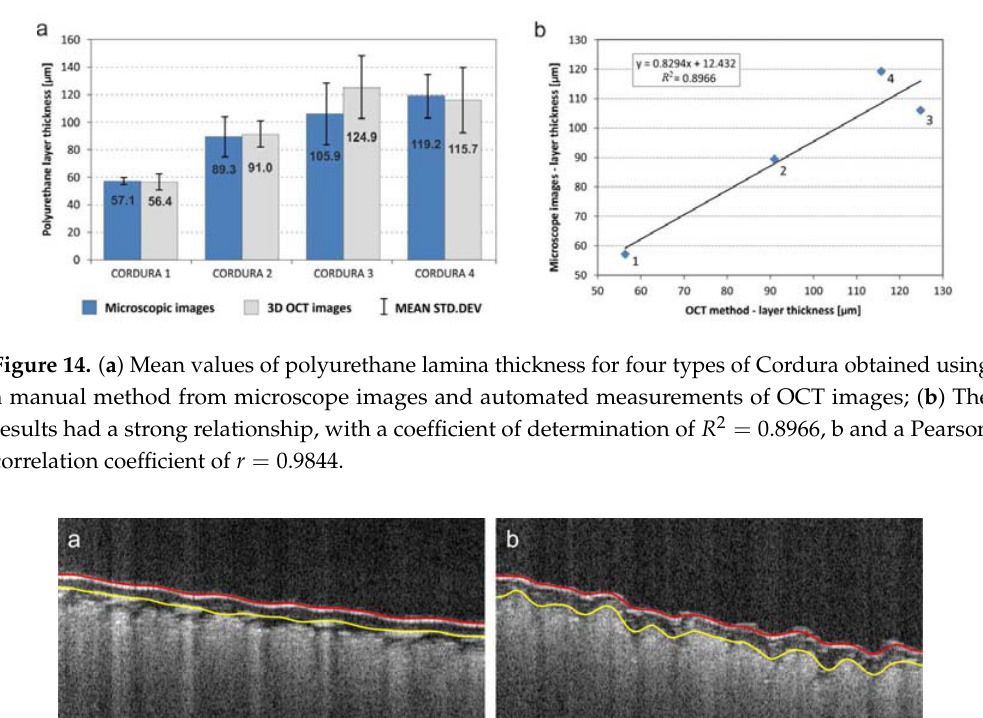
13 of 17 Figure 13. Exemplary thickness maps of the polyurethane layers in different Cordura samples (categories): ( a ) perspective view; ( b ) internal boundary depth; ( c ) XY ‐ plane). The mean thicknesses and standard deviations of the cover layers of the tested Cordura samples (categories) were averaged over the 10 scanning regions, as described in Section 2.4. The values are